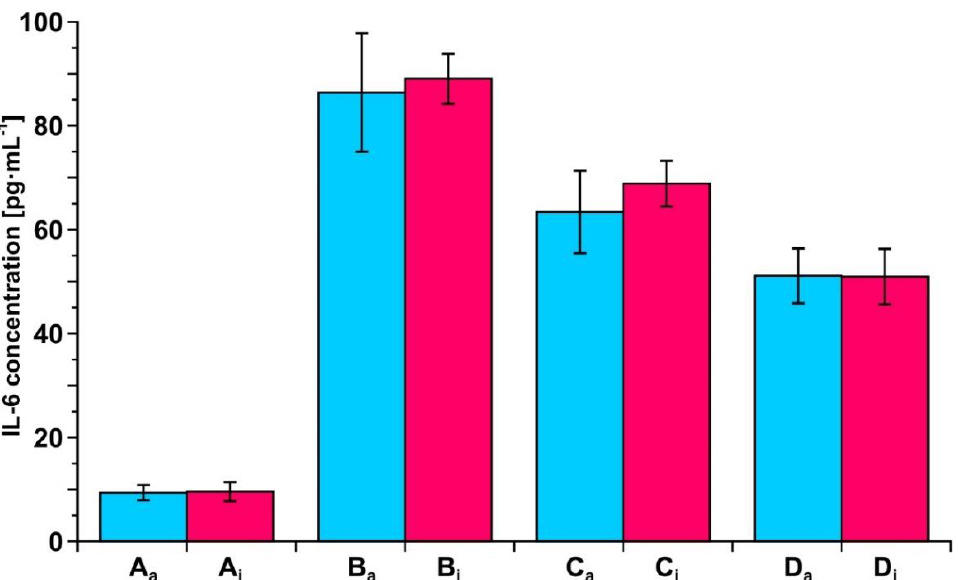
Figure 6. Changes in IL-6 concentration in the blood plasma of a patient before and after resection of ovarian tumor, as determined by the biosensor with the antibody as the receptor (blue) or the biosensor with the inhibitor as the receptor (red). A: control, B: before resection, C: 6 h, D: 24 h and E: 5 days after resection.